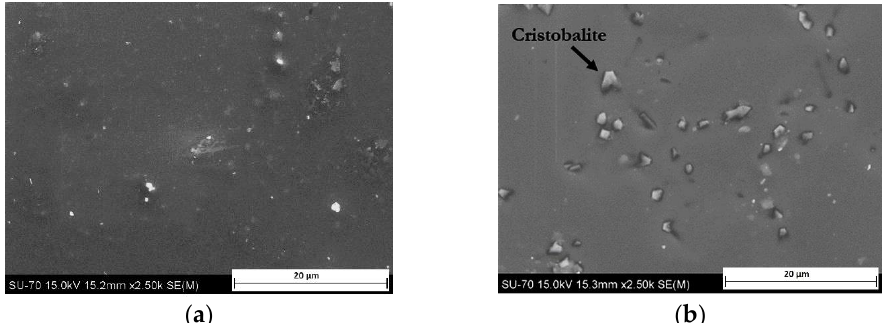
Figure 5. SEM images from the glaze surface of a new porcelain plate ( a ) before; ( b ) after accelerating chemical aging.